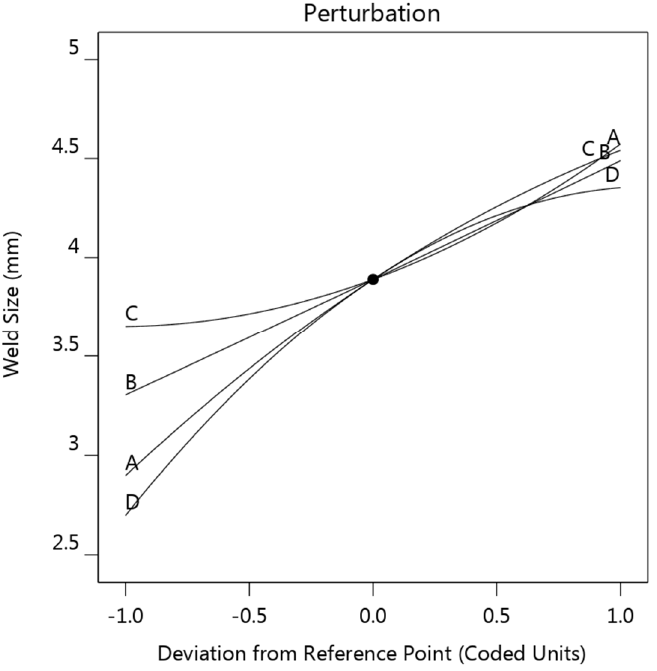
Figure 10. Perturbation plot showing the effect of the four factors on the weld diameter (strip thickness ( A ), welding current ( B ), strip resistivity ( C ), and sheet thickness ( D )).